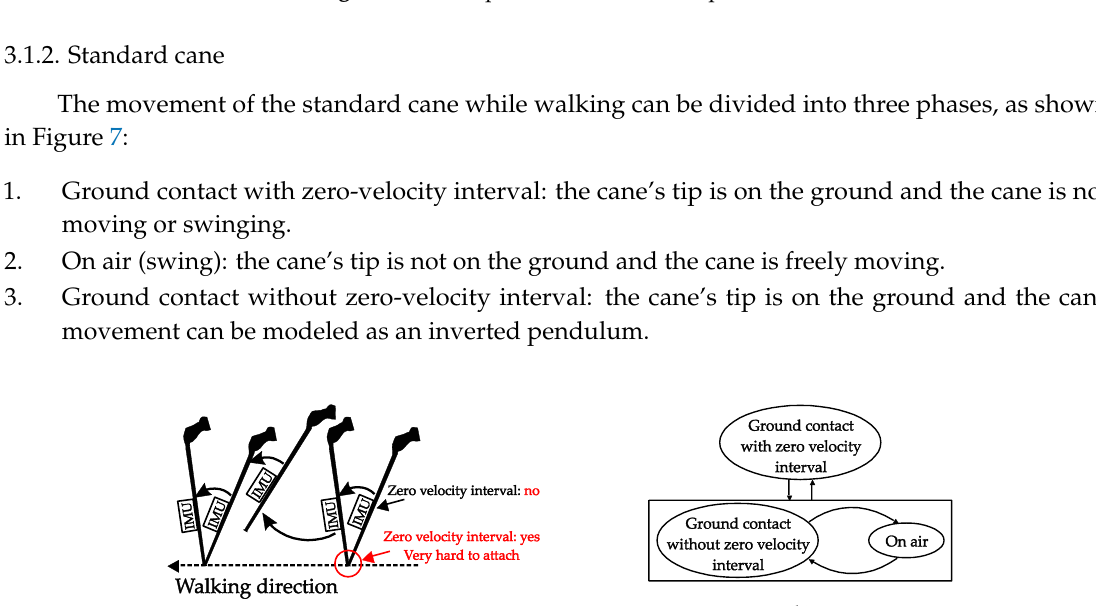
Figure 7. Standard cane movement: ( a ) Visualization; ( b ) State diagram.